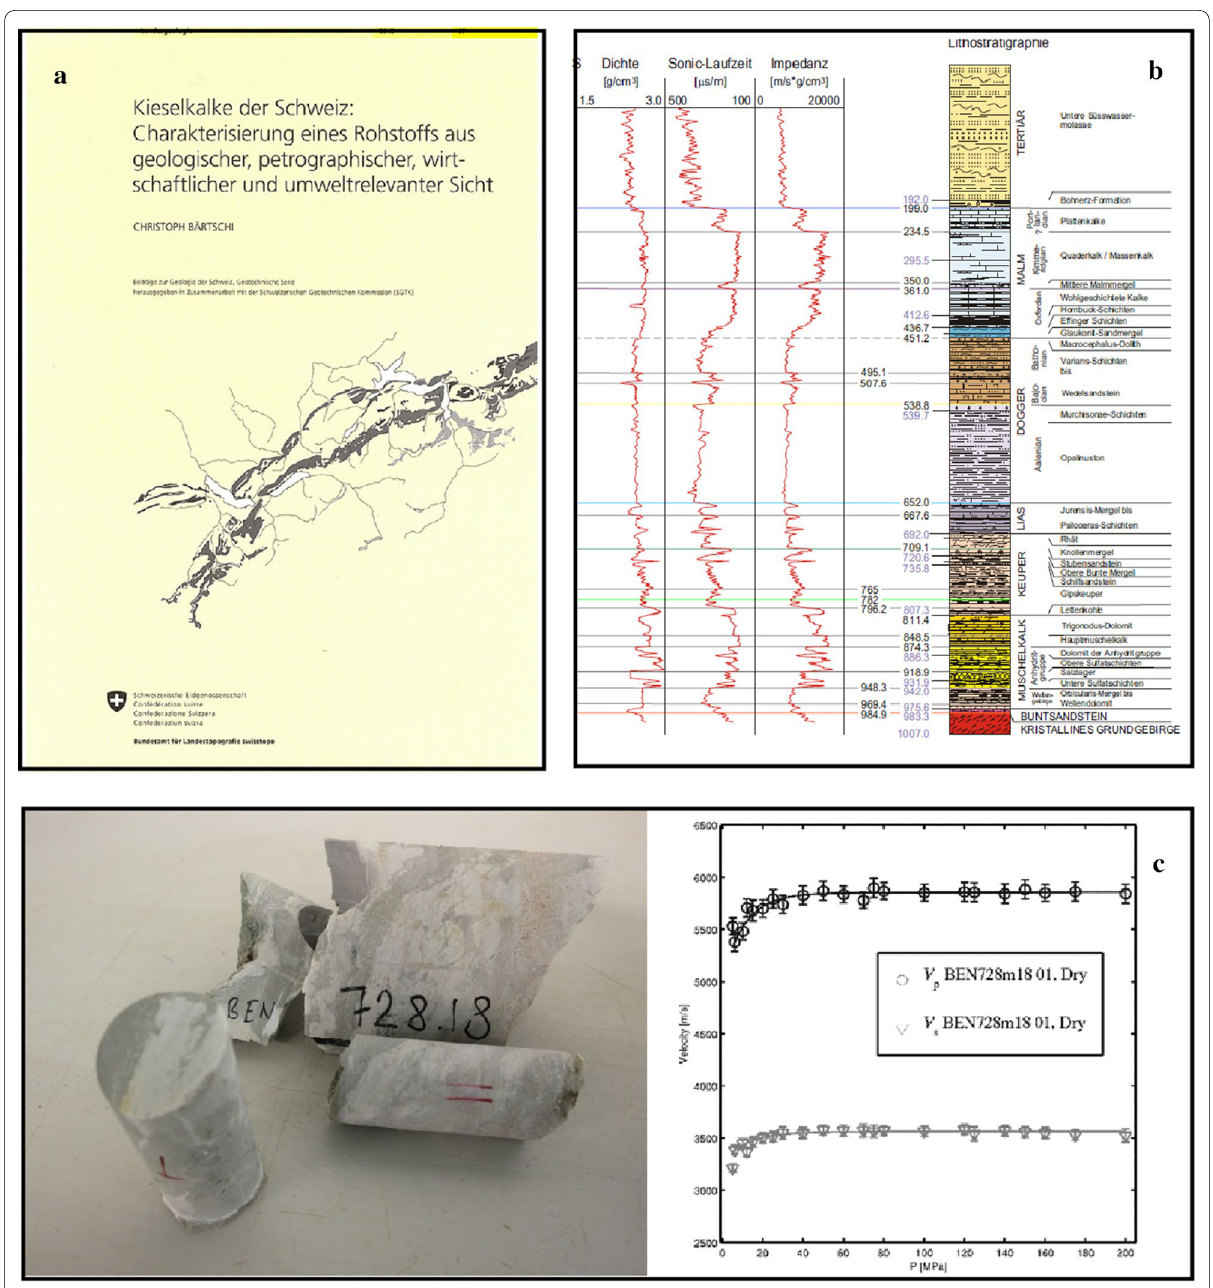
Fig. 3 Examples of data sources: published data from scientific literature ( a ), borehole data [modified after Technischer Bericht 00-01 NAGRA ( b ); newly collected data ( c